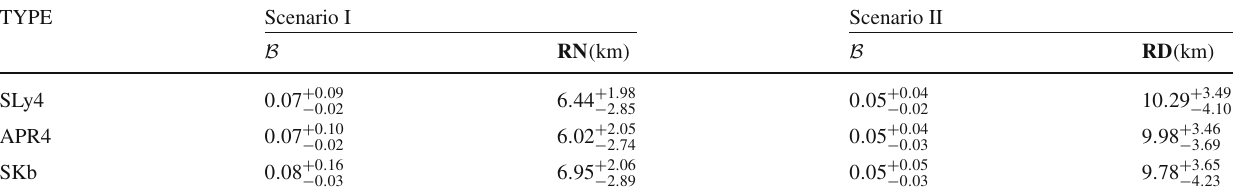
Table 2 The inferred best-fitted values of the EoS parameter B and the core-radius r W for scenario I and II of hybrid stars, with three different choices of neutron EoS